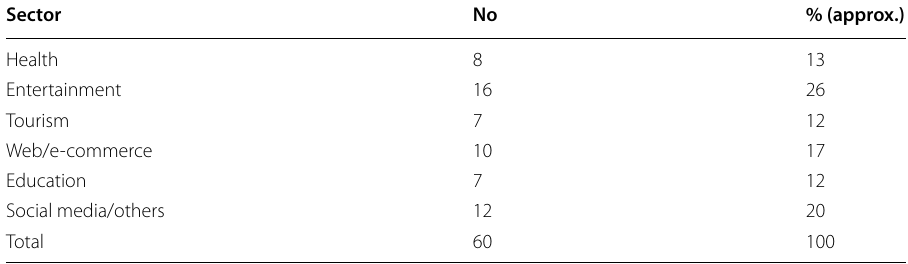
Table 4 Sector-wise article